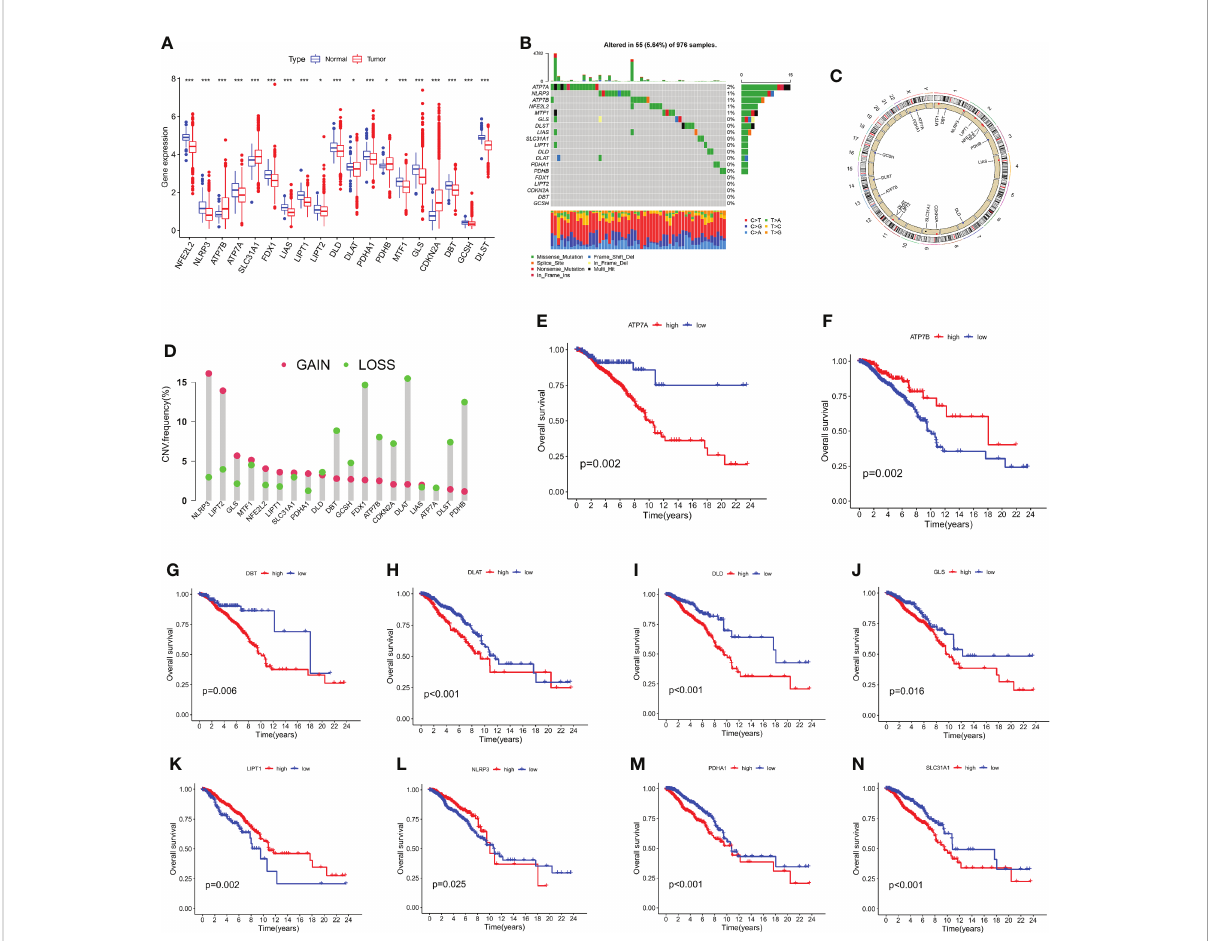
FIGURE 1 The analysis of 19 CRGs' expression and association in the TCGA cohort. (A) The expression of the 19 CRGs in BC tissues and healthy breast tissues (* p < 0.05; *** p < 0.001). (B) Data on the frequency of CRG mutations for 976 BC patients. (C) The sites of CNV variation in CRGs on the 23 chromosomes. (D) The distributions of CNV gain, loss, and non-CNV among CRGs. (E – N) The association between 10 CRGs and overall survival in British